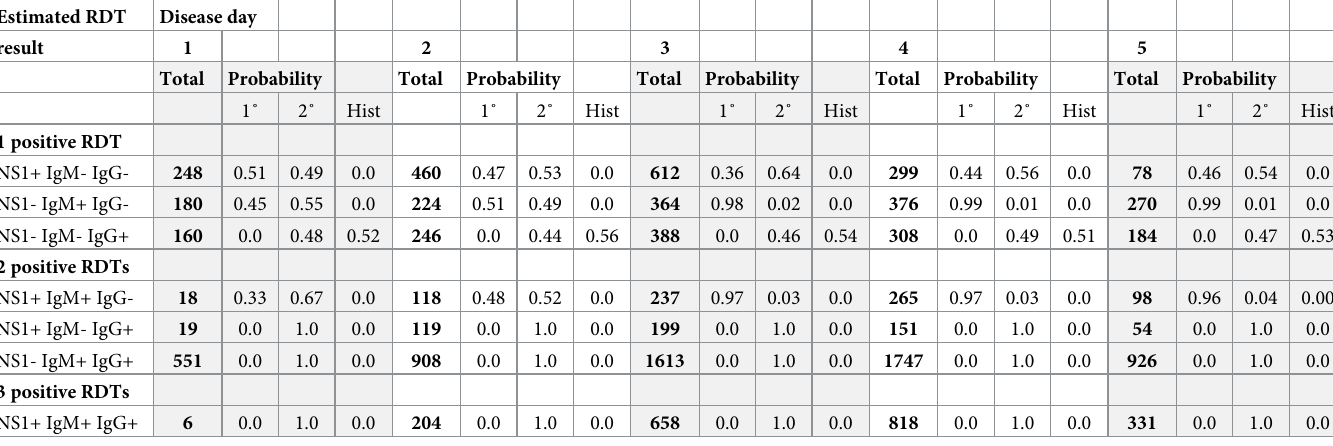
Table 3. The probability of being primary, post-primary or historical for DENV according to every outcome combination of NS1, IgM and IgG RDTs stratified by disease day. RDT results estimated among patients from across the Philippines (N: 28,326). Estimated RDT Disease day result Total Probability 1 positive RDT NS1+ IgM-